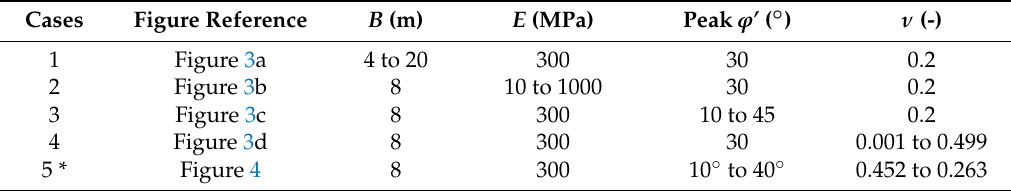
Table 1. Geometric and mechanical characteristics of the numerical models simulating the backfilled